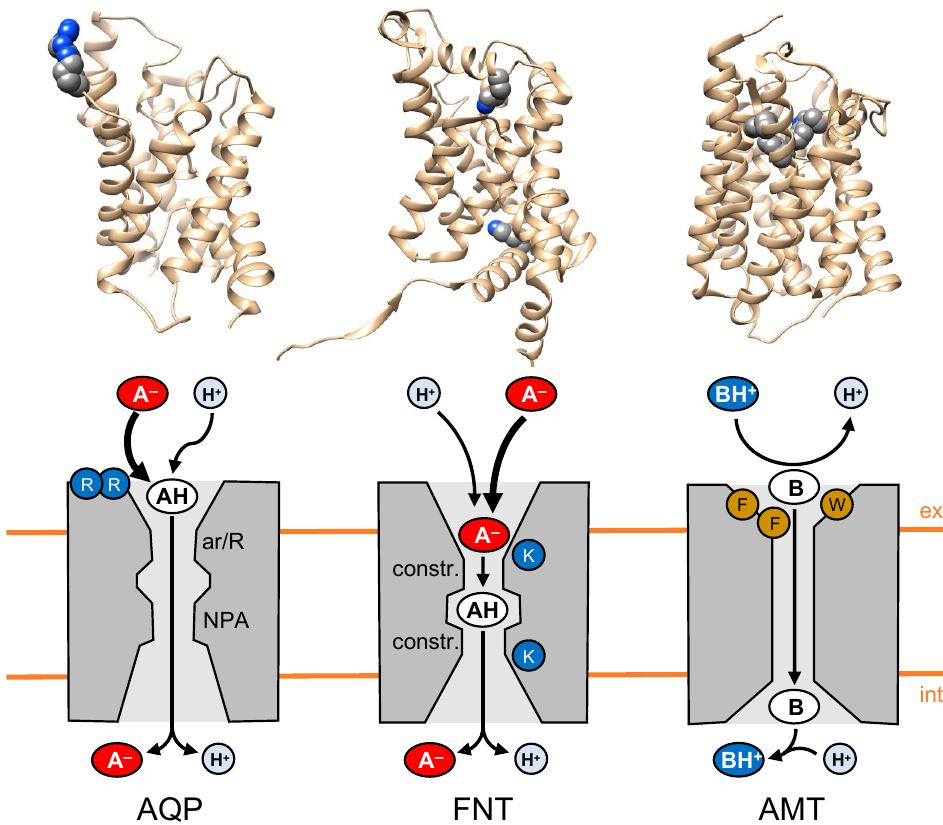
Figure 1. Schematic representation of models on the substrate binding, neutralization, and transduction of lactic acid-facilitating aquaporins, AQP (left; structure model), formate-nitrite transporters, FNT (center; PDB# 6vqq), and ammonium transporter/methylammonium permease/mammalian Rhesus proteins, AMT/MEP/Rh (right; PDB# 1u7g). Key amino acid residues are shown as spheres in the cartoons (backbone: sand; carbon: gray; nitrogen: blue).